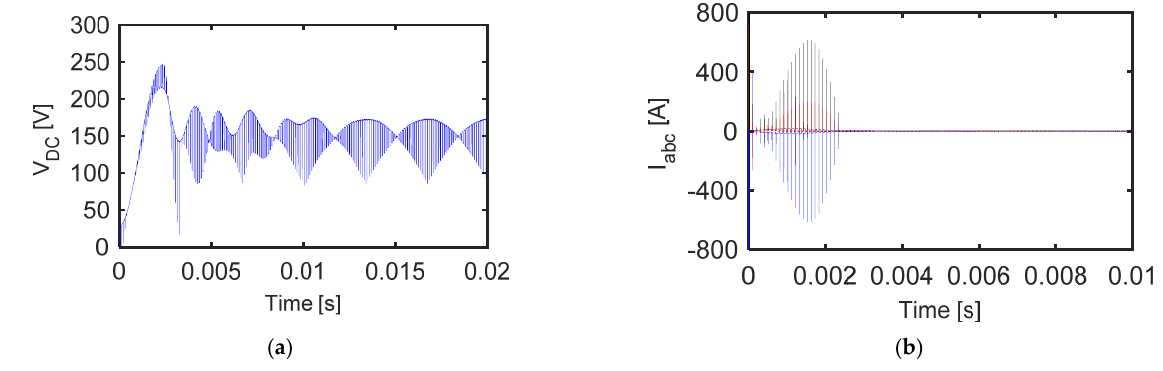
Figure 6. Simulation testing of the clamping circuit at start-up with operation of the PWM of the rectifier ( a ) DC-link voltage and ( b ) input current for